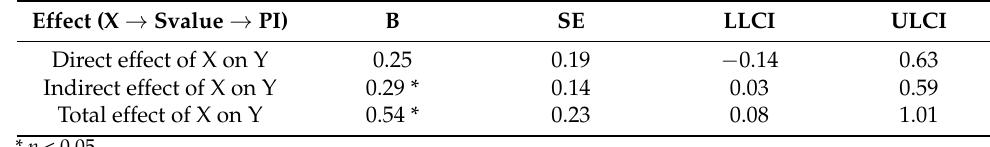
Table 1. Regression analysis of the mediating effect.